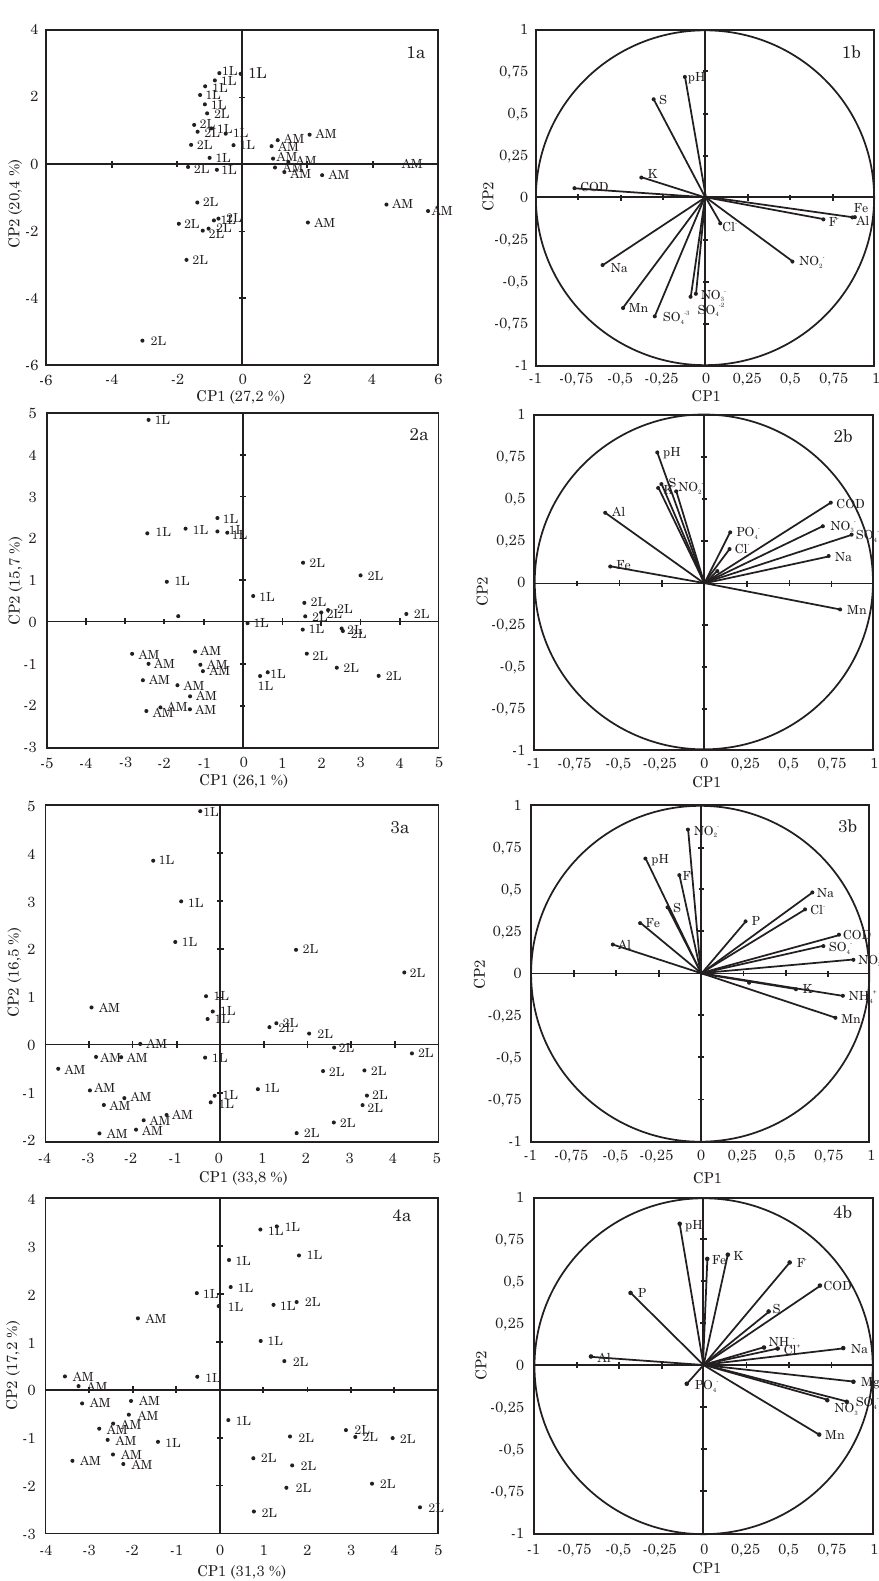
Figura 1. Gráficos de scores (a) e loadings (b) para a análise de componentes principais da solução do solo nas quatro amostragens realizadas. 1) 22 meses; 2) 26 meses; 3) 37 meses; e 4) 46 meses, após a ultima aplicação de lodo na área experimental. AM: adubação mineral; 1L: dose de lodo recomendada; e 2L: dobro da dose de lodo recomendada com base na cultura do